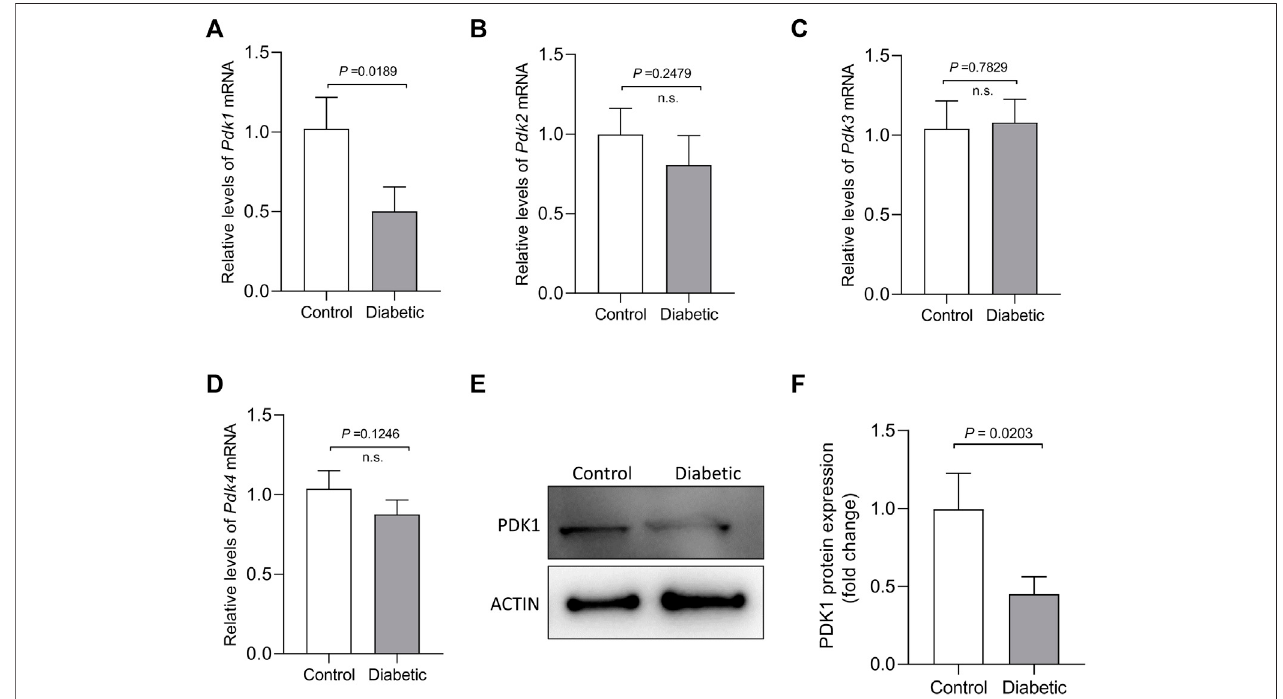
FIGURE 1 | Reduced PDK1 expression in oocytes from diabetic mouse. (A – D) Quantitative RT-PCR analysis of Pdks mRNA levels in oocytes from control and diabetic mice. (E – F) Western blot analysis showed the decresed expression of PDK1 protein in oocytes from diabetic mice compared to controls. Actin served as an internal control. Band intensity was calculated using ImageJ software. Data are expressed as the mean percentage ± SD of three independent experiments.